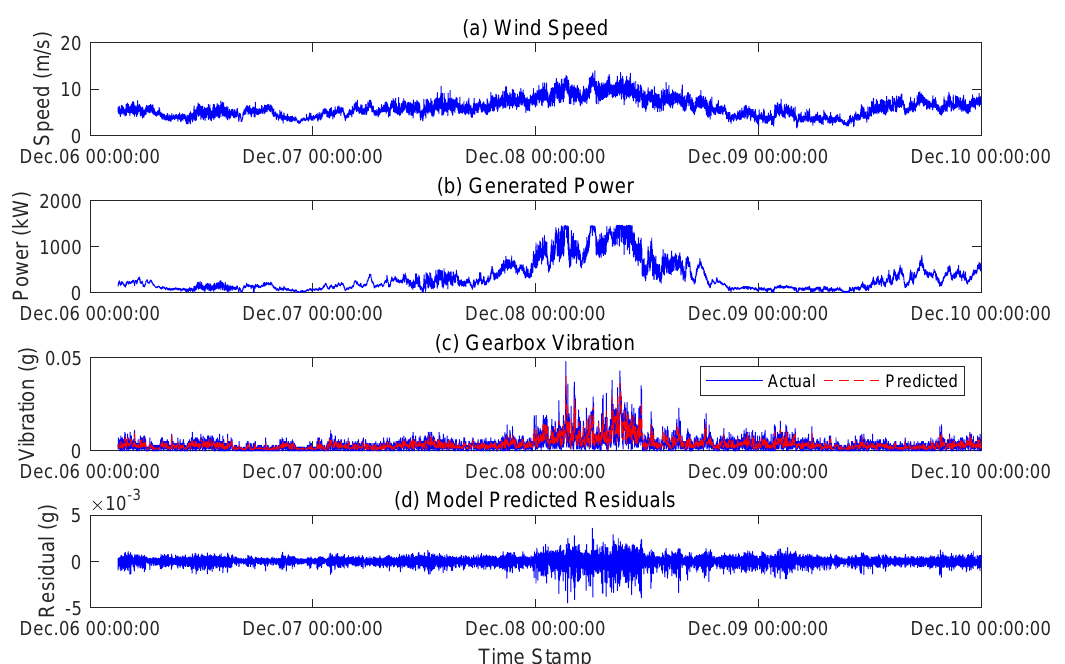
Figure 11. Residuals of the validation set and its corresponding wind speed, active power and gearbox